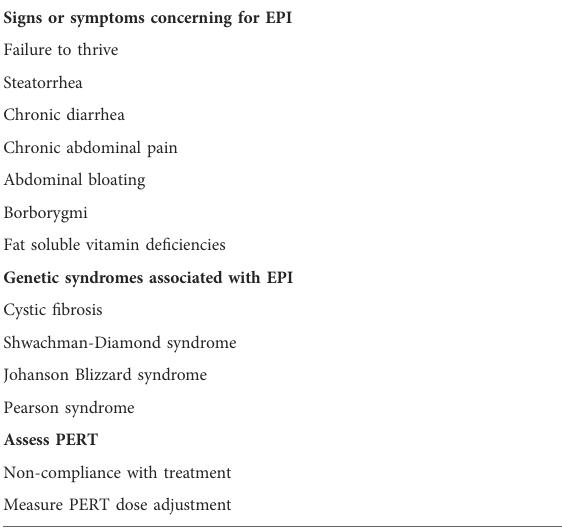
TABLE 2 Indications for the assessment of exocrine pancreatic